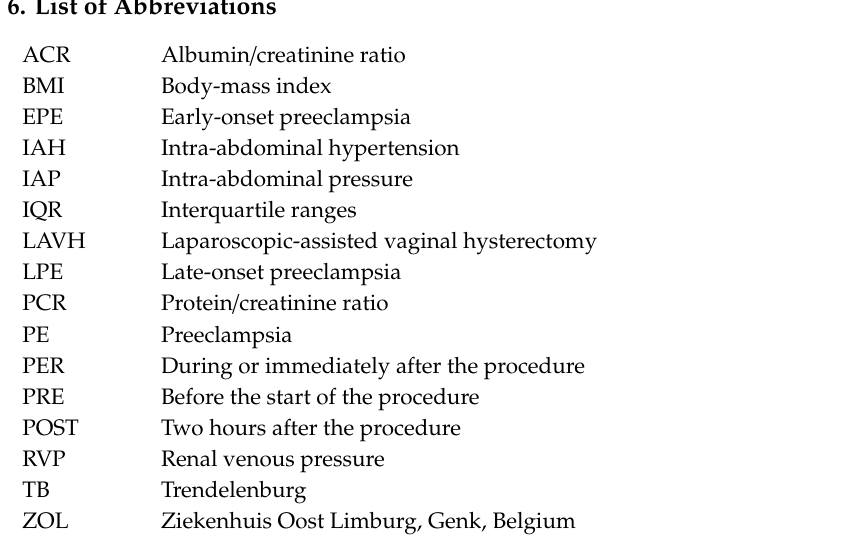
Table S1: Reference ranges of the analyzed urinary renal function parameters. Table S2: Parity and detailed medication usage of subjects in both study groups. Table S3: Urine analysis of both the intervention and the control group at di ff erent time